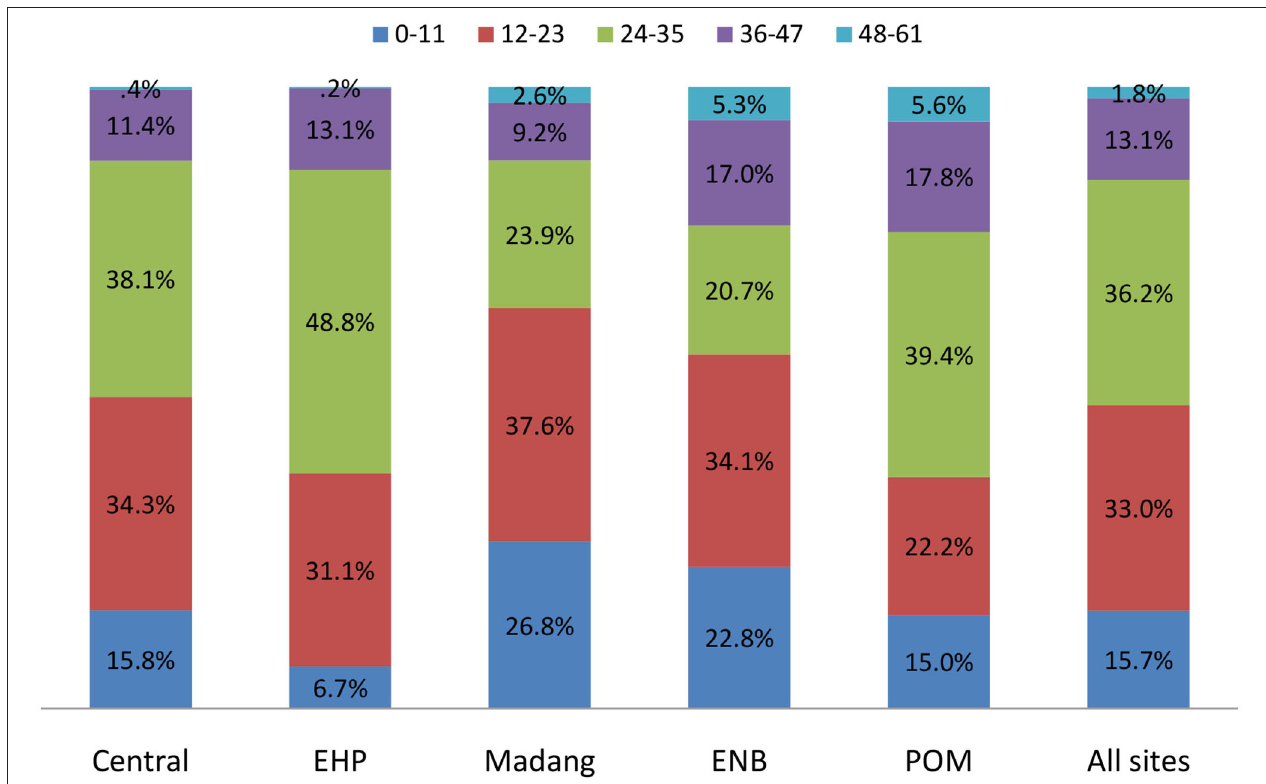
FIGURE 4 | Distribution of child participants by total dietary diversity scores by province, PNGIMR’s CHESS,